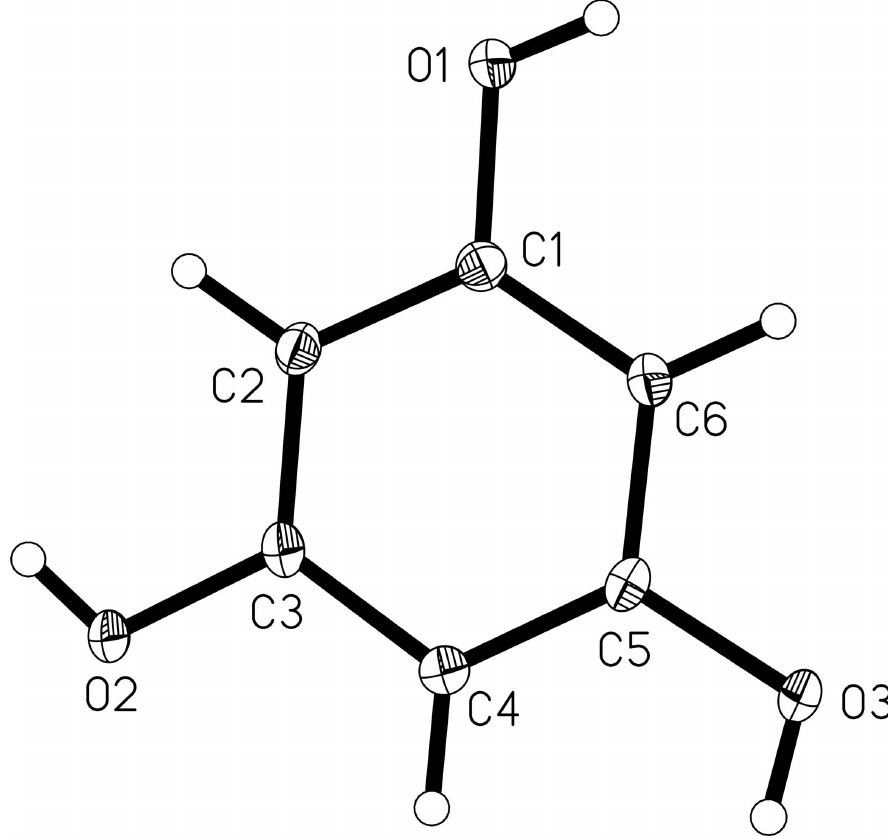
Figure 1 The molecular structure of the title compound. Displacement ellipsoids are shown at the 50% probability level and H- atoms are shown as spheres of arbitrary